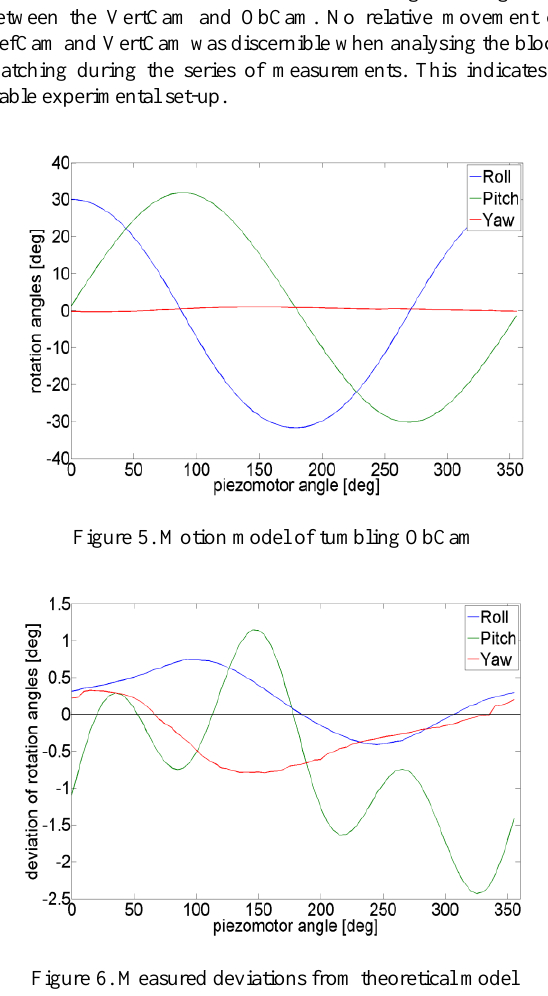
Figure 6. Measured deviations from theoretical